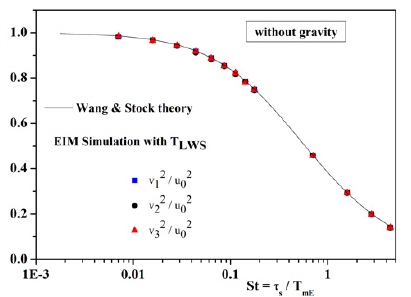
Figure 7. Normalized variance of particle velocity (g = 0).